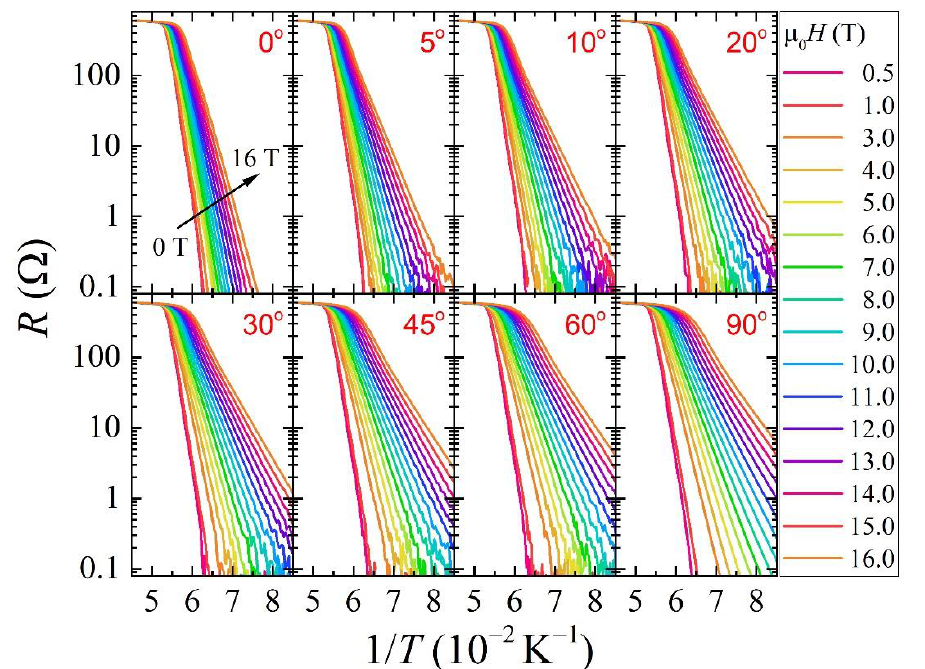
Figure 1. A selection of the acquired R ( T ) at different applied magnetic fields for the different field direction are displayed in Arrhenius plots.